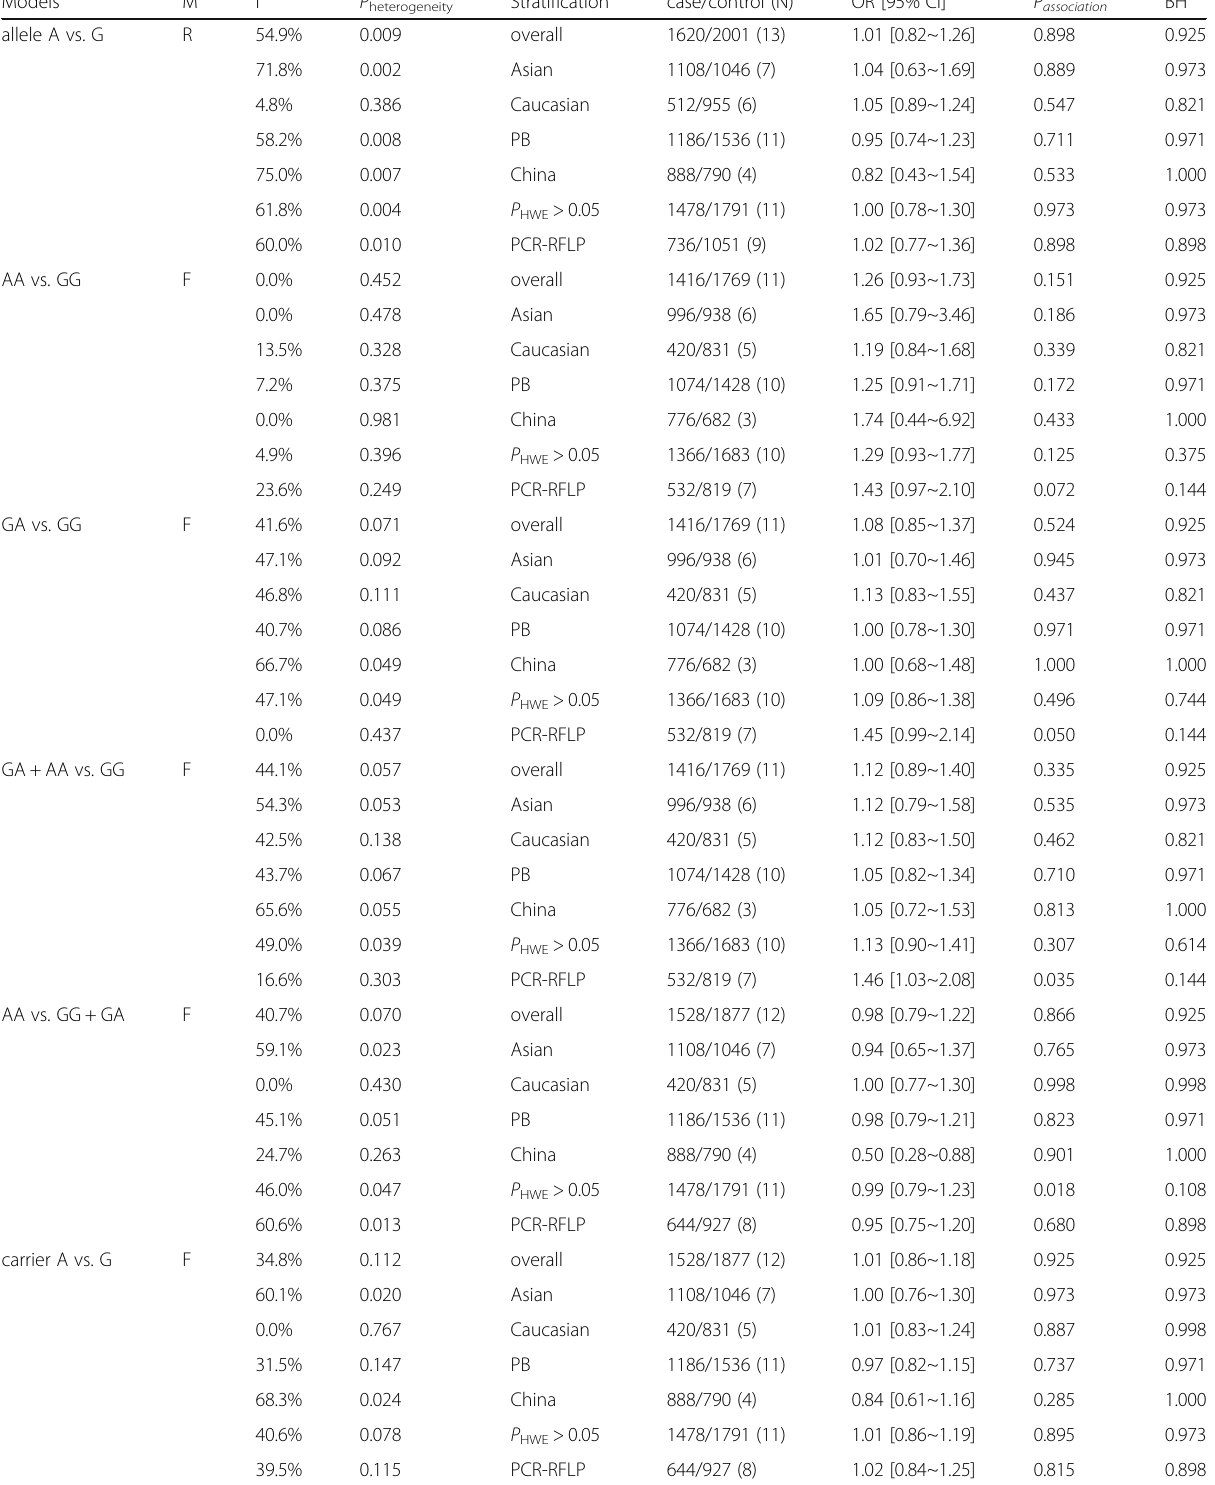
Table 3 Pooled analyses of the association between VDR rs1544410 polymorphism and susceptibility to psoriasis